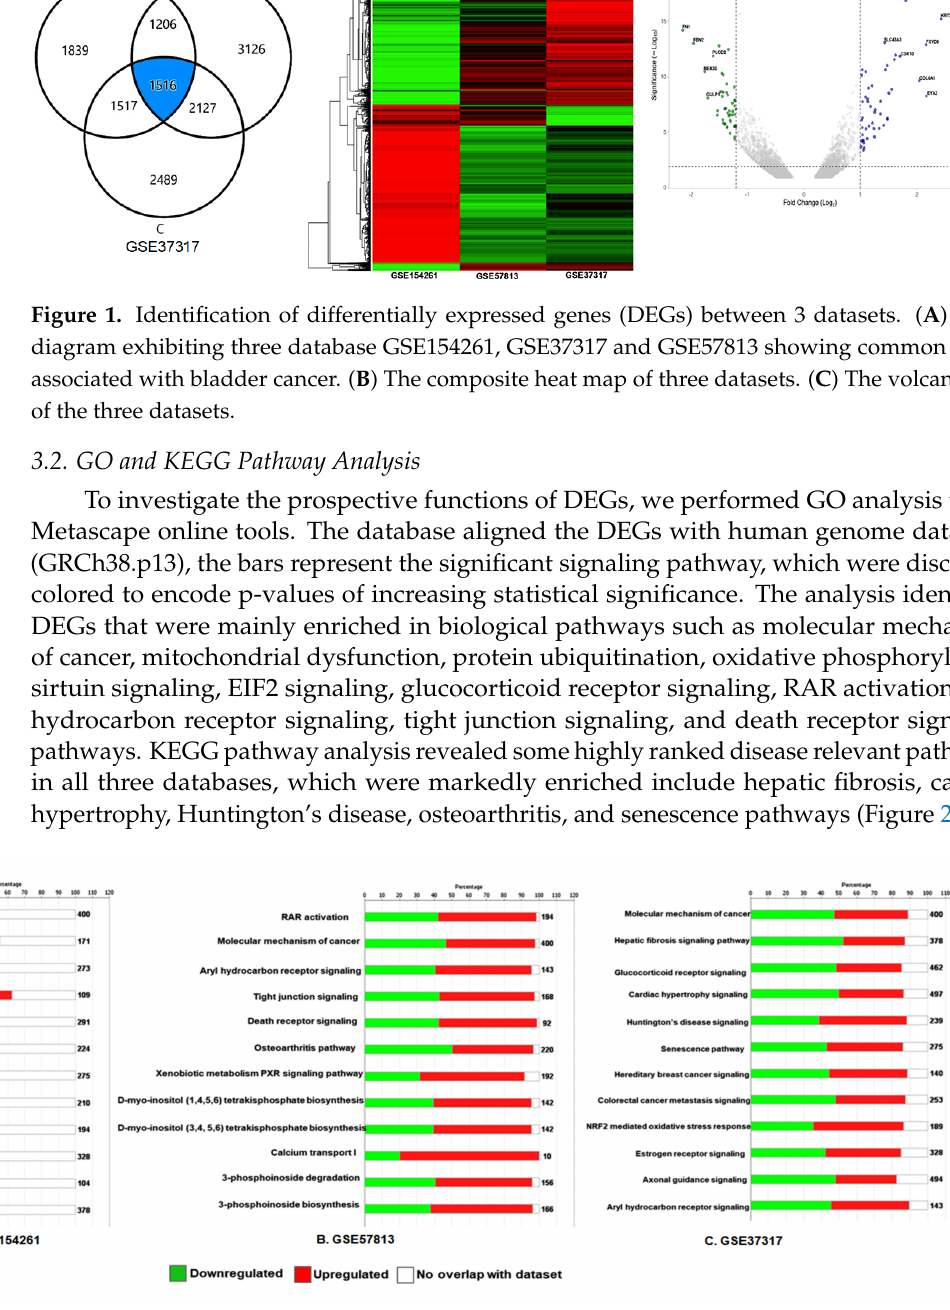
Figure 2. GO and KEGG pathway analysis of DEGs in bladder cancer. Bar diagram of three datasets ( A ) GSE154261, ( B ) GSE37317, and ( C ) GSE57813 analyzed for bladder cancer. Significant pathways with p -values < 0.01 were